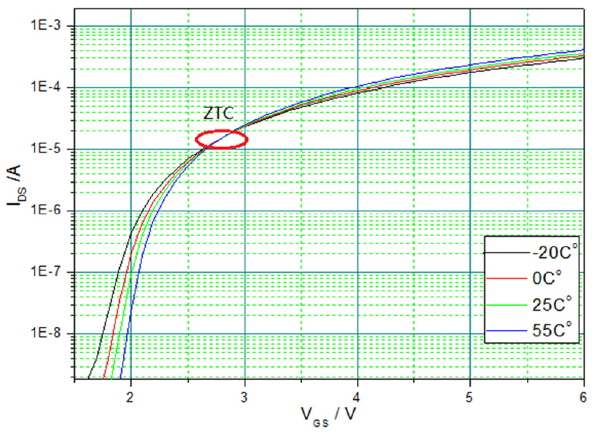
Figure 7: Schematic diagram of I – V curve cluster and ZTC point of PMOS at di ff erent temperatures.